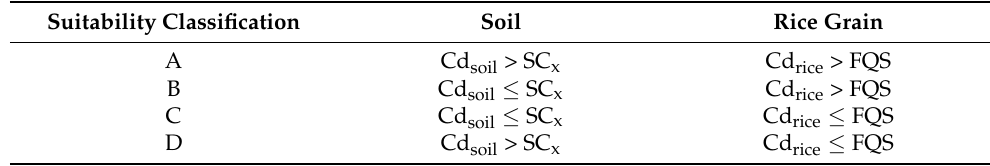
Table 1. Suitability classification of the soil–rice paired samples. Suitability Classification